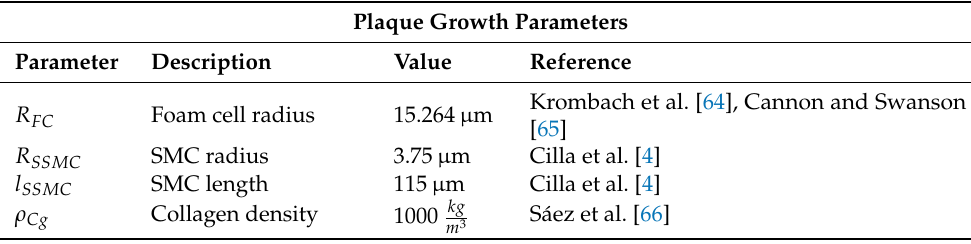
Table 4. Parameters to calculate plaque growth in the arterial wall.